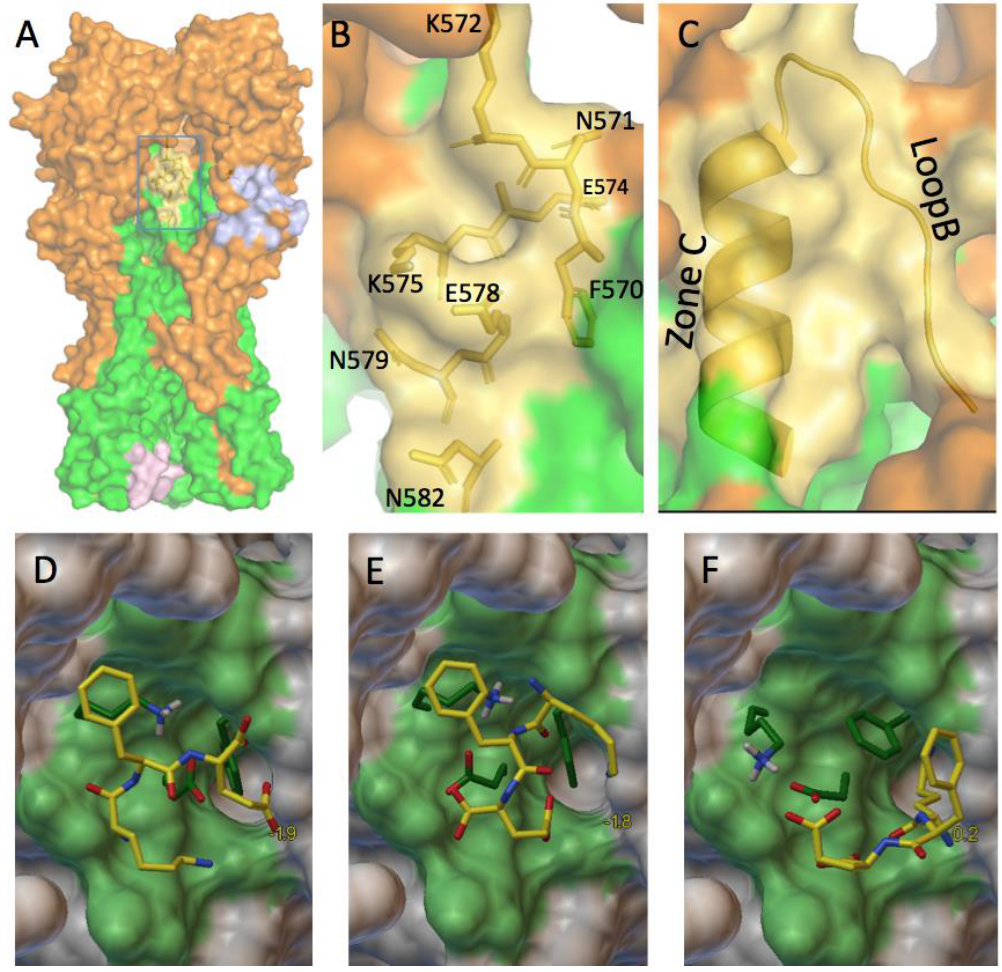
Figure 9. A possible future tripeptide drug. ( A ) A 3D view of H1N1 hemagglutinin. In yellow, the third target; ( B ) An enlarged view of the blue box of Figure 9A depicting the amino acids constituting the third target; ( C ) An enlarged view of the blue box of Figure 9A where the helix C and the loop B are positioned; ( D)–(F ) Three proposed docking of the tripeptide KFE on the third target.